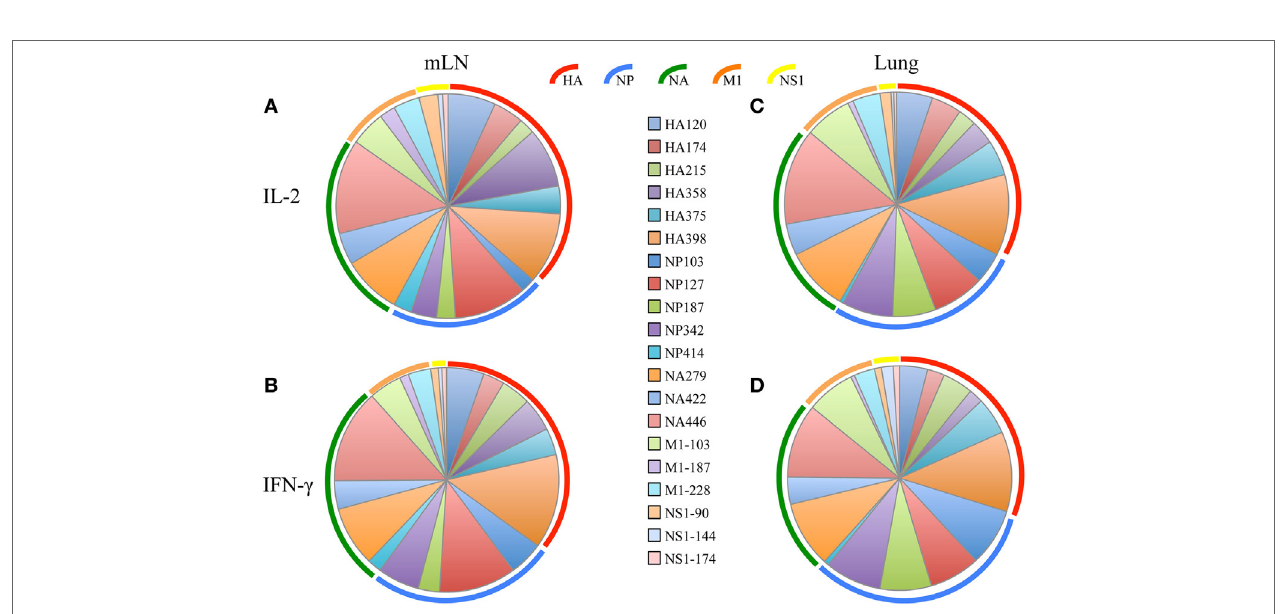
FigUre 3 | Virus-specific CD4 T cell diversity in the draining lymph node (dLN) and lung. The number of peptide specific IL-2 producing CD4 T cells was quantified at day 10–11 postinfection by cytokine ELISPOT assay as indicated in Figure 2 . The average percent response recruited by each peptide was calculated by the dividing the number of cytokine EliSpots elicited by the given peptide by the sum of the EliSpot responses elicited by all of the peptides tested. This percent response value is represented as a “slice” of the pie for mediastinal lymph nodes (mLN) (a,b) and Lung (c,D) for IL-2 (a,c) and IFN- γ (b,D) . The different color arcs indicate the source protein each epitope. Each individual epitope is indicated by a different colored slice of the pie and is colored for each peptide as indicated in the center panel. Results represent the average of the three independent experiments shown in Figure 2 with the indicated SD.